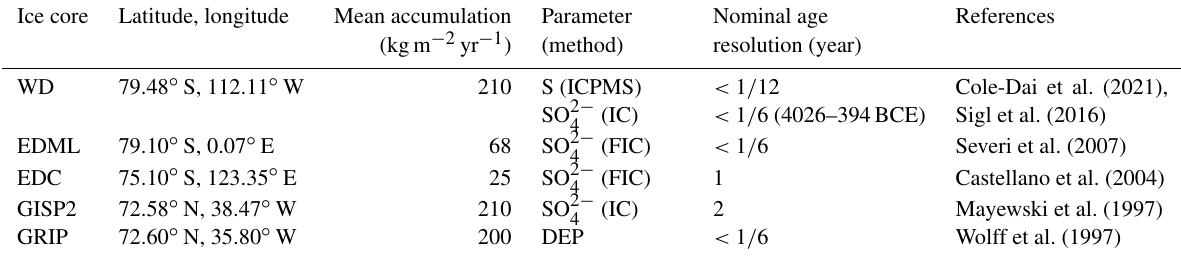
Table 1. Ice-core records and analytical methods used (ICPMS: inductively coupled plasma mass spectrometry; IC: ion chromatography; FIC: fast ion chromatography; DEP: dielectric profiling) Ice core